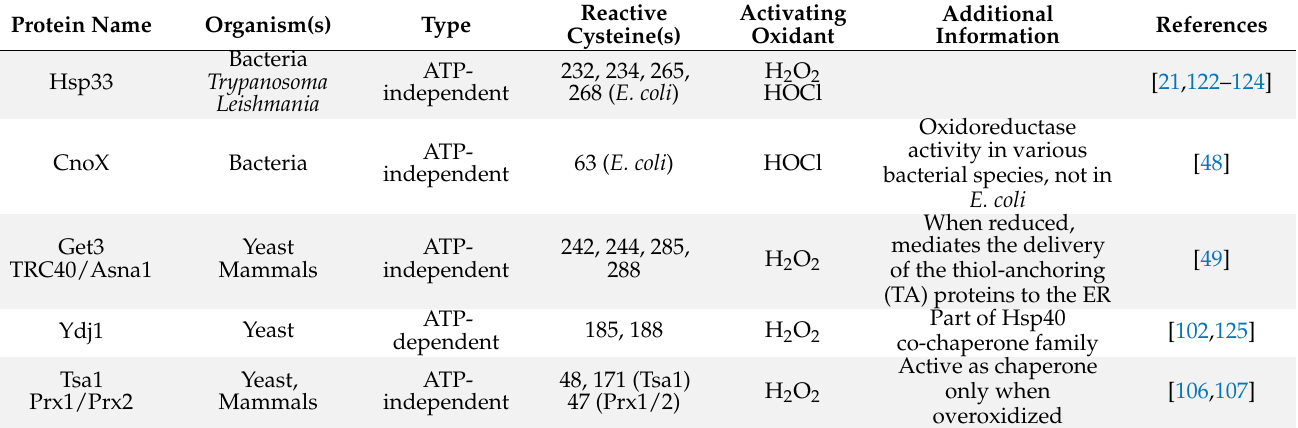
Table 1. Table summarizing select chaperones involved in maintaining protein homeostasis through redox regulation.